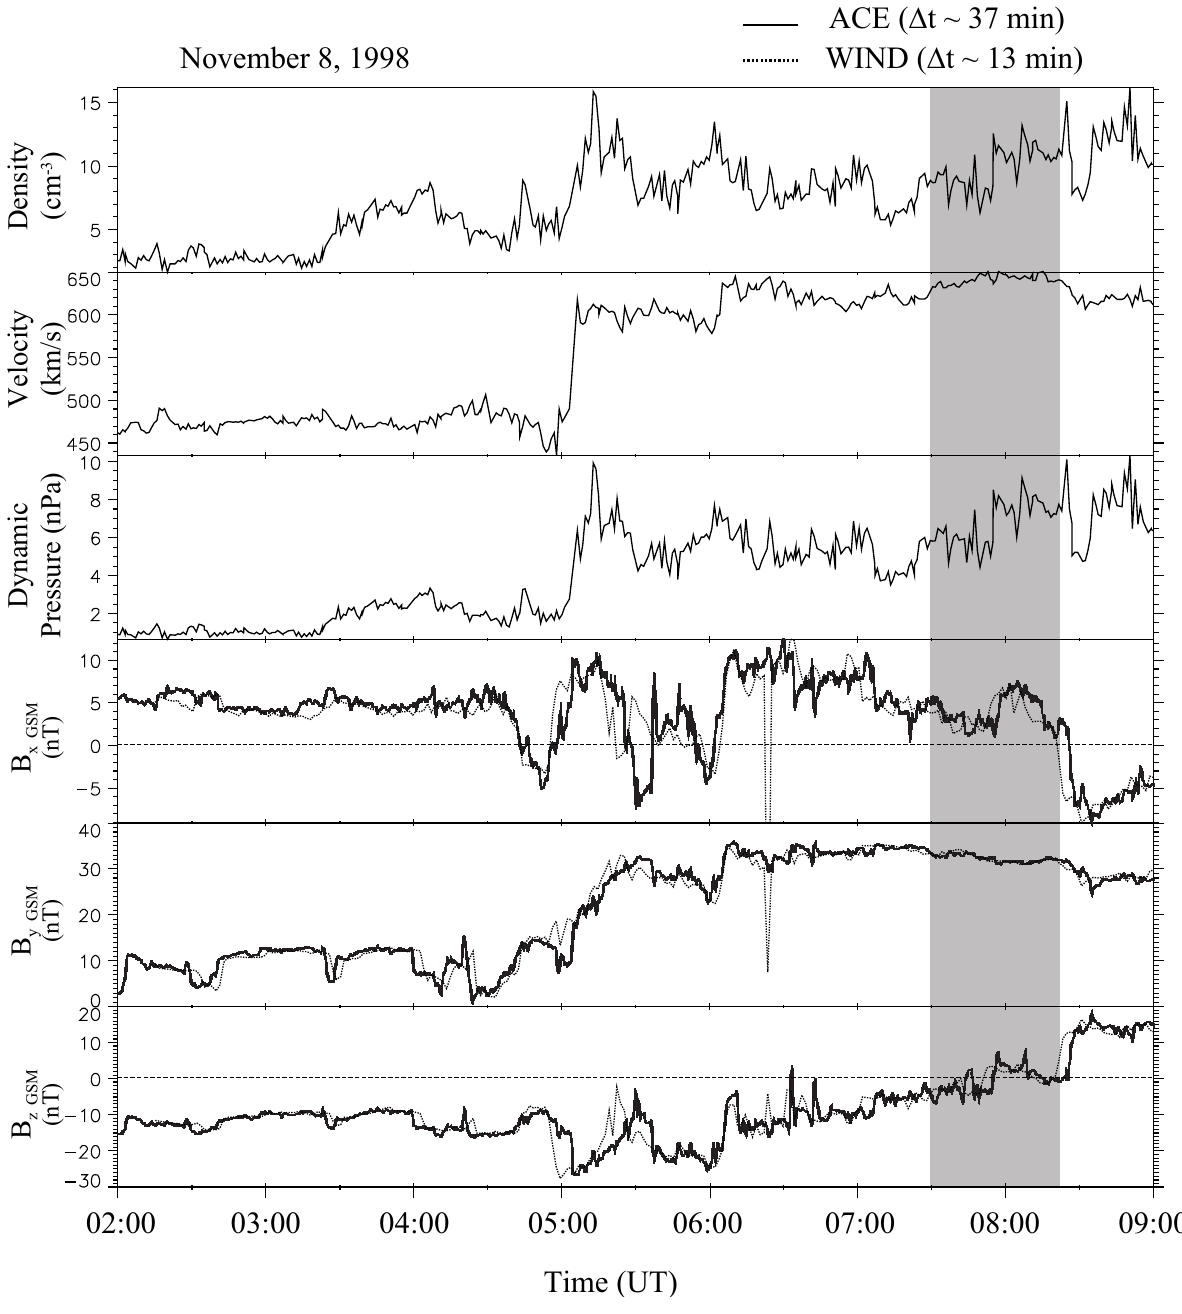
Fig. 1. Plasma (density, velocity and dynamic pressure) measurements obtained on board ACE and magnetic field components measured on board ACE (solid line) and WIND (dashed line) in the solar wind on 8 November 1998 between 02:00 and 09:00 UT. The time delay necessary for the plasma to reach the Earth’s magnetosphere has been taken into account. The gray area corresponds to the cusp measurements by Interball